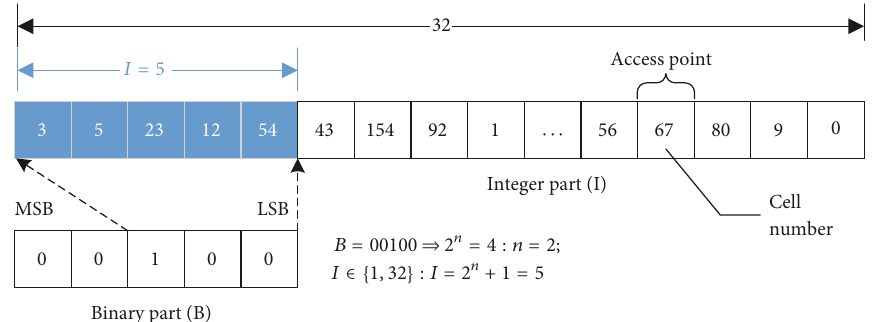
Figure 3: Coding scheme of the chromosome utilized in